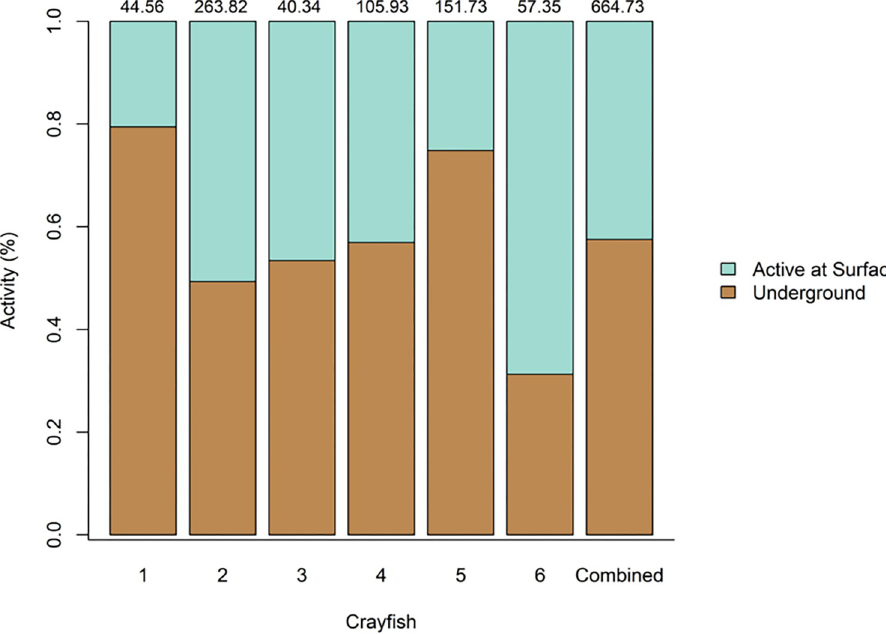
Fig 5. The percentage of time that Lacunicambarus thomai spent visible at the surface of their burrow (active at surface) or not visible underground in their burrow (underground). We report the percentage of time that each crayfish individual spent active or inactive as well as a combined total for all six crayfish. For each crayfish, the total number of time (hours) that each crayfish was filmed is listed above each